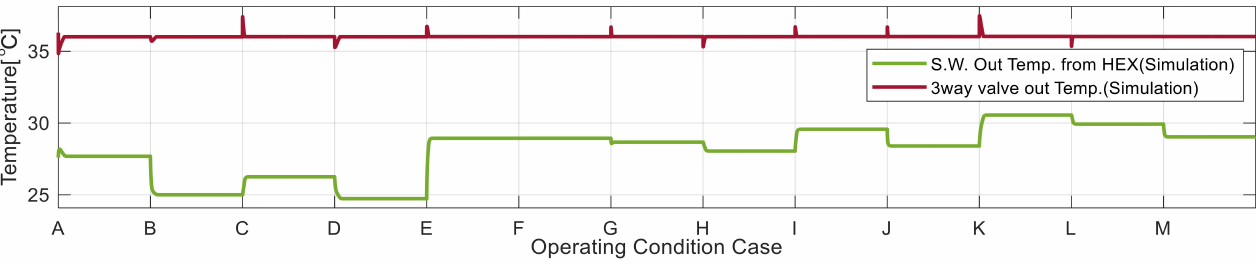
Figure 11. Simulation graph for FW outlet temp. at 3-way valve and SW outlet temp.